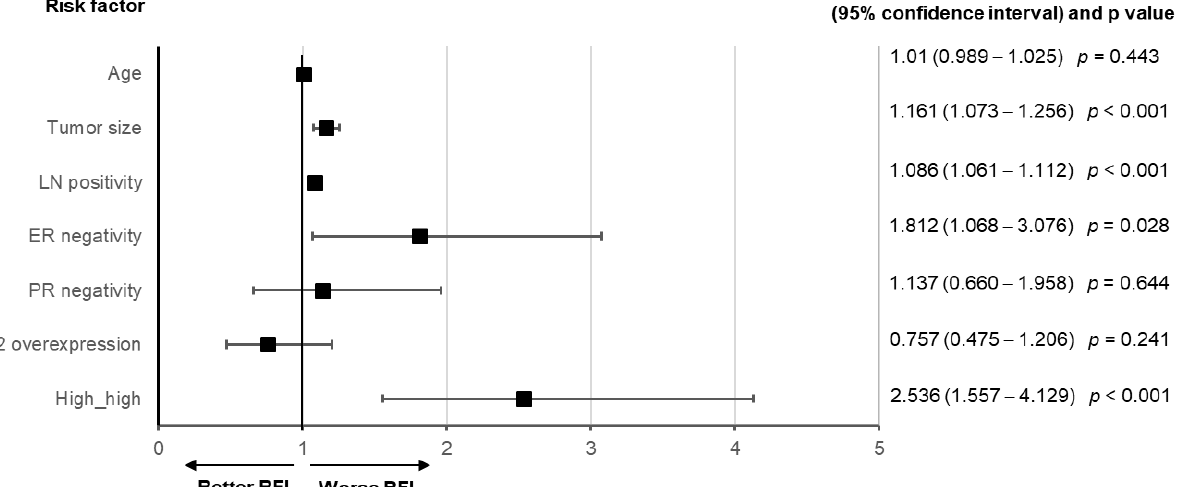
Figure 5. Effect of clinical factors and the combined factor of the tumor-to-aorta ratio (TAR) of Hounsfield units on contrast-enhanced computed tomography larger than 0.27 and the serum neutrophil-to-lymphocyte ratio (NLR) larger than 1.61, represented as ‘high-high’ on recurrence- free interval (RFI). Multivariate analysis with Cox’s proportional hazard model showed that tumor size, metastatic axillary lymph node disease, negativity of estrogen receptors, and high-high were significant independent prognostic factors. The hazard ratios and confidence intervals are provided on the left side of the plot.